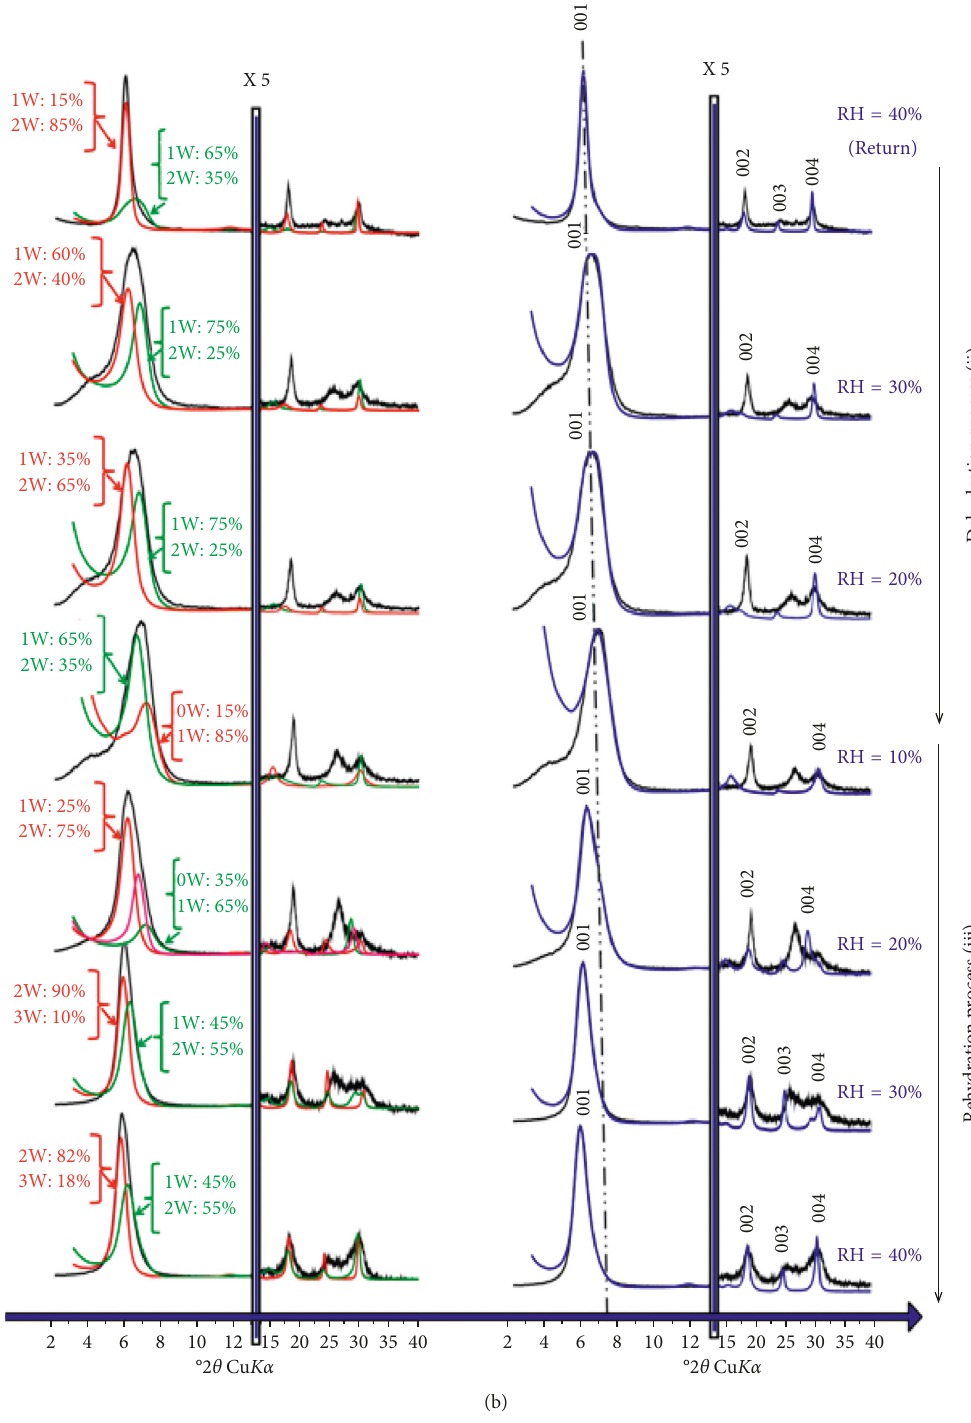
Figure 2: Best agreement between experimental (black line) and calculated (blue line) XRD patterns obtained using the respective contributions of the various MLSs (red and green line) in the case of the first cycle. (a) Hydration-dehydration. (b)